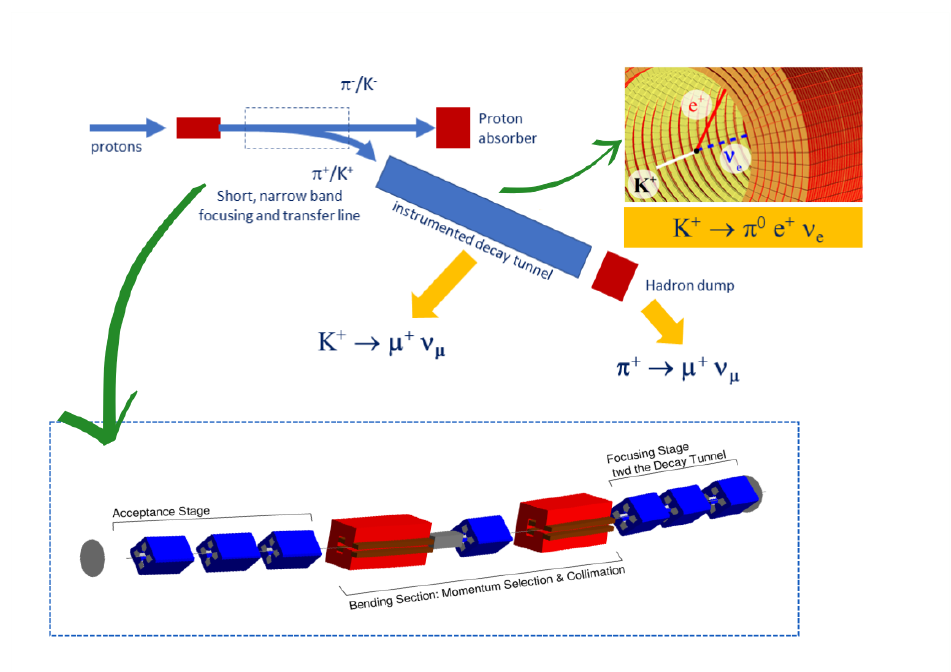
Figure 10. Schematics of the ENUBET facility. The decay volume instrumentation is shown in the top right inset; the (horn-less) focusing and transfer line is shown in the bottom